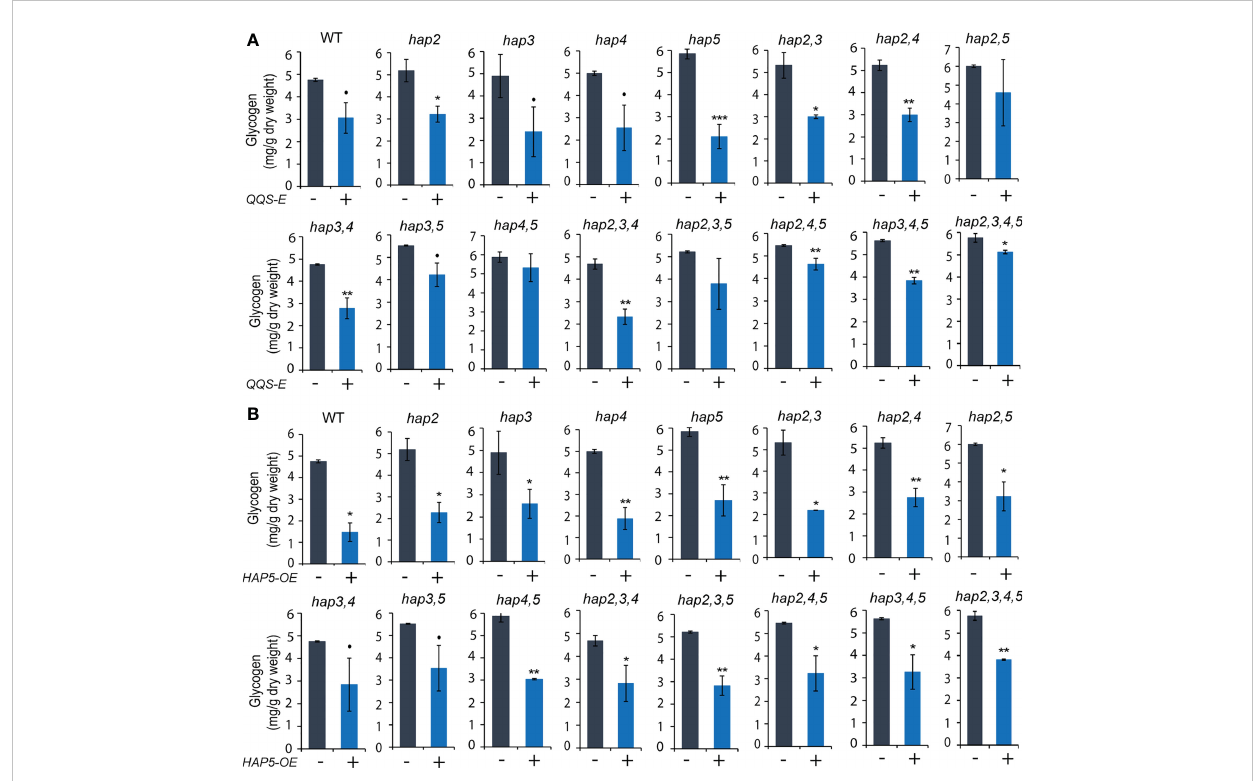
FIGURE 6 The effect of transgenic QQS-E and HAP5-OE on the glycogen content of yeast hap mutant strains. (A) QQS-E . (B) HAP5-OE . All data are mean ± SE, n = 3. Statistical signi fi cance relative to the strains without QQS-E or without HAP5-OE was calculated with Student ’ s t -test and is indicated: ** P < 0.01, * P < 0.05, (cid:129) P <